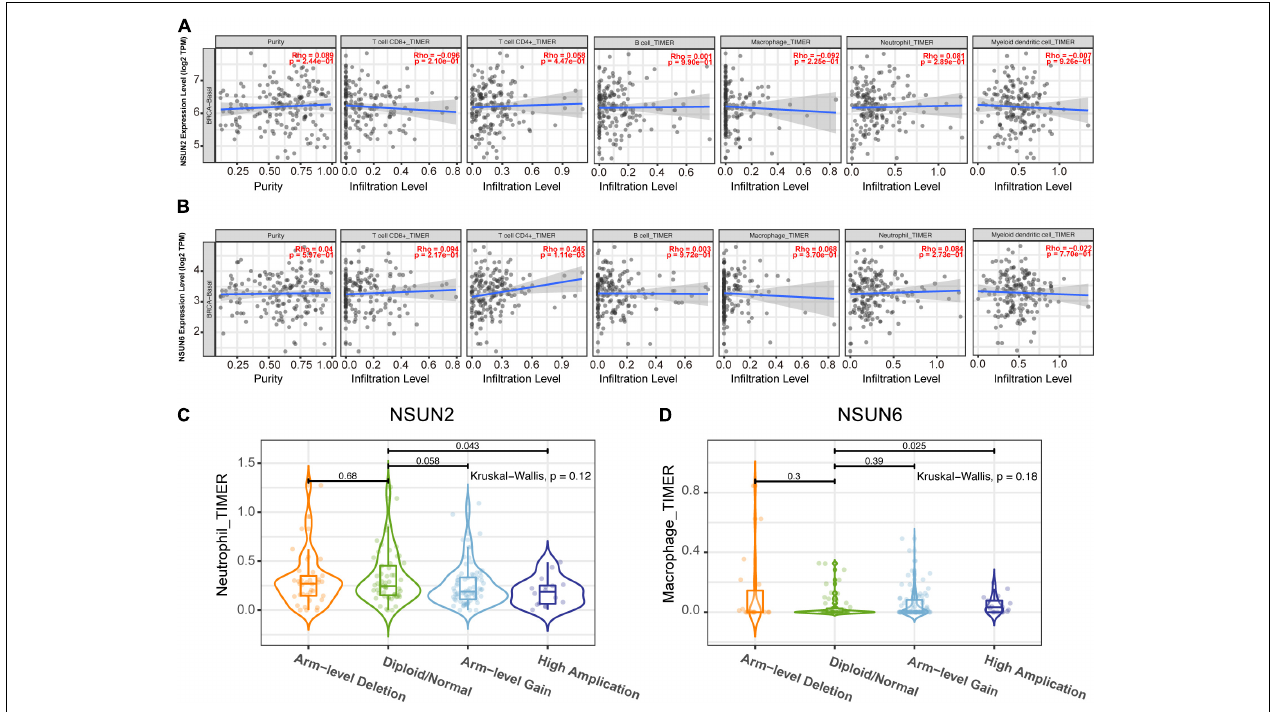
FIGURE 7 | Correlation between prognostic-related genes and TIM. Correlation analysis of NSUN2 and NSUN6 with the infiltration level of the 6 main immune cells after adjusting for the purity (A,B) . Analysis according to different groups of somatic copy number alterations showed a significant difference in NSUN2 expression at the neutrophil level (C) and NSUN6 expression at the macrophage level (D) among these groups. TIM, tumor immune microenvironment; NSUN, NOP2/Sun domain family